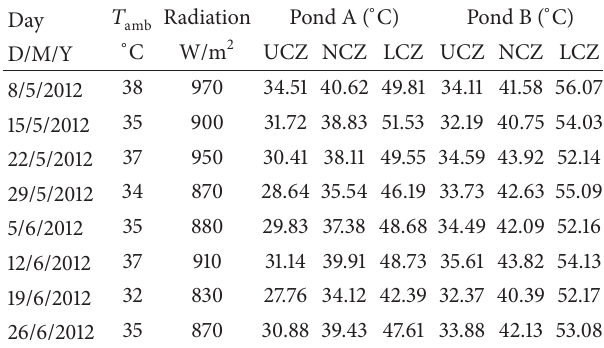
Table 2: Temperature variation of three different zones of solar ponds “A” and